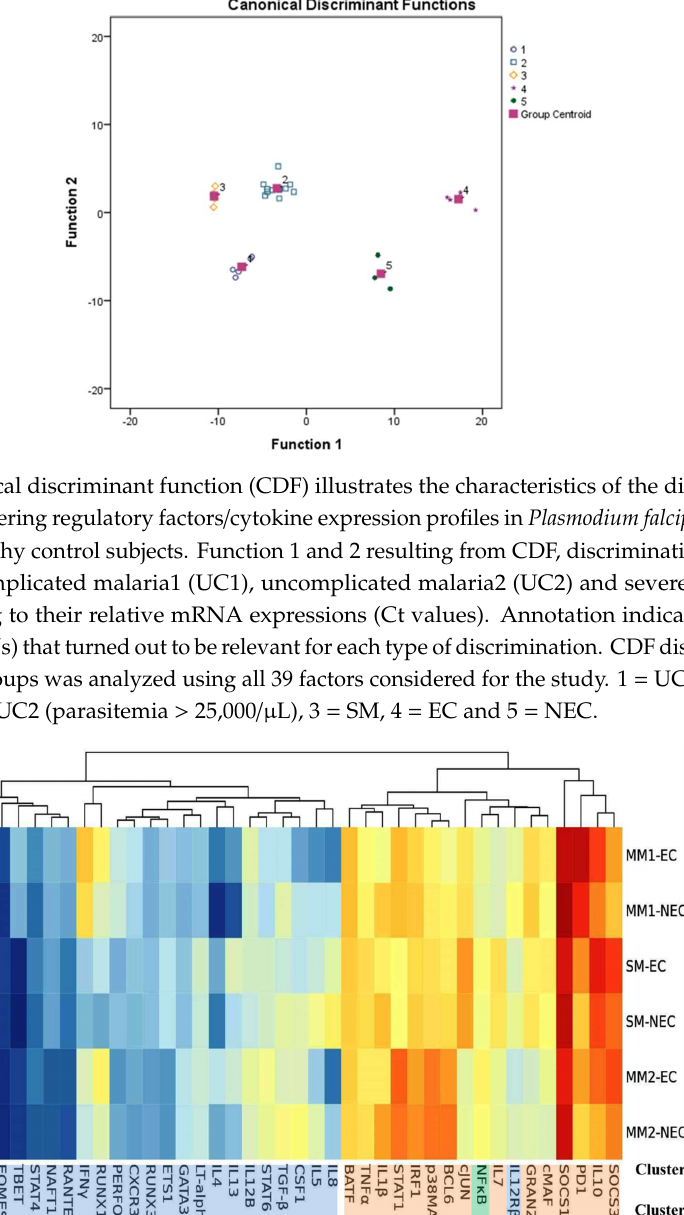
non-endemic control; UC2-EC, uncomplicated malaria group (parasitemia > 25,000 / µ L) fold change compared to endemic control; UC2-NEC, uncomplicated malaria group (parasitemia > 25,000 / µ L) fold change compared to non-endemic control; SM-EC, severe malaria group fold change compared to endemic control; SM-NEC, severe malaria group fold change compared to non-endemic